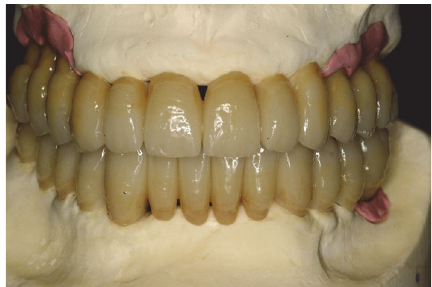
Figure 25: Second set of temporaries: frontal view.